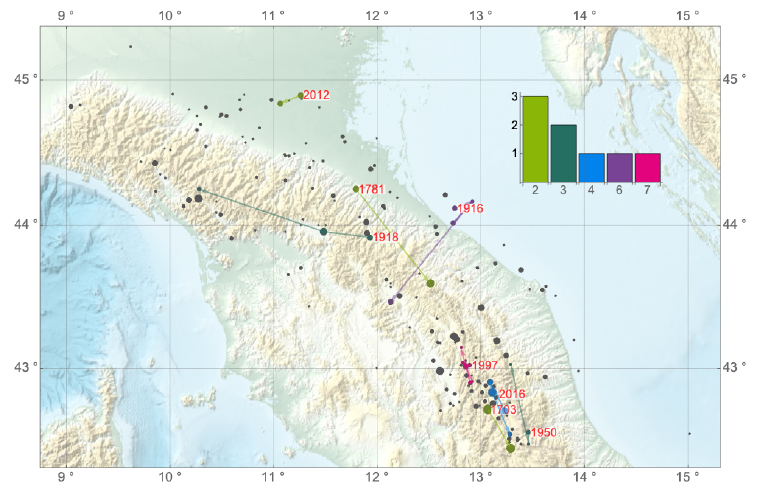
Figure 2. Epicenters of CPTI15 catalog from 1650 to 2020, with M w ≥ 5.0. Colored lines join mainshocks of the same sequence recognized by algorithm and described in text and in Table 1. The colors indicate the number of mainshocks for each sequence (the three sequences consisting of two mainshocks are shown in light green, and so on; see histogram in